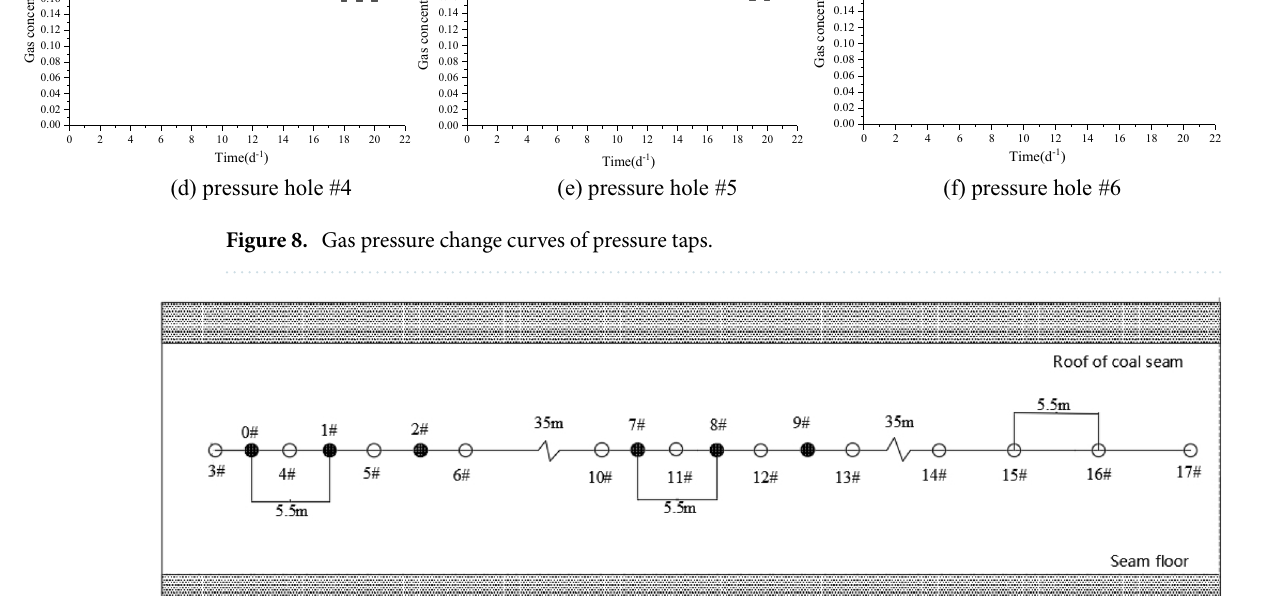
Figure 9. Schematic diagram of the drilling construction at the test